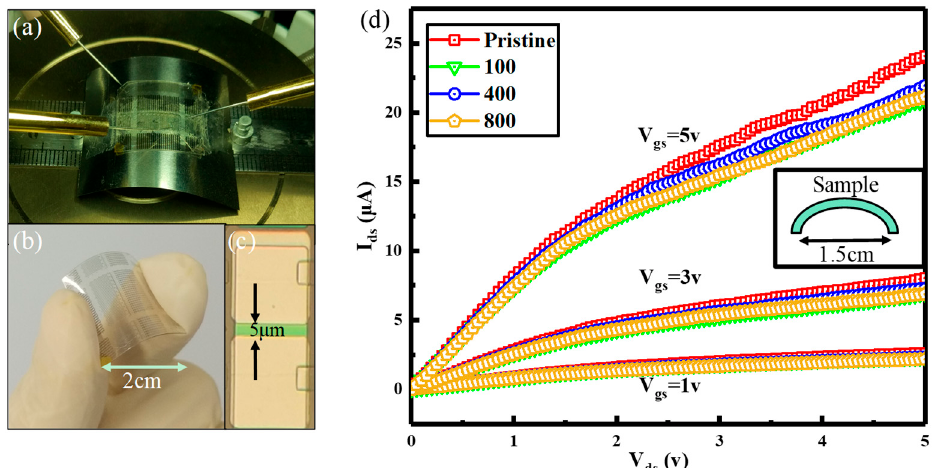
Figure 6. ( a ) The image of the flexible TFTs fixed on a probe station with the bending radius of 0.75 cm. ( b ) Shows the digital photographs of the flexible TFTs. ( c ) Shows an image of one device of TFTs under an optical microscope. ( d ) Shows the electrical characteristics of the flexible TFTs with a bending radius of 0.75 cm after being bent several times.